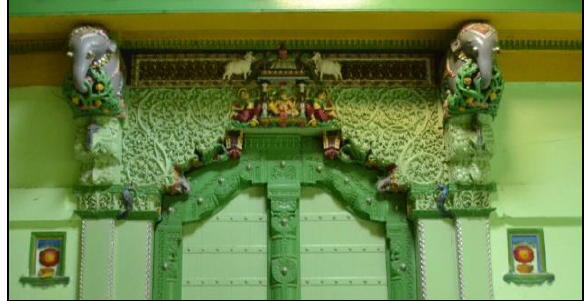
Figure 3. A traditional door highlighting the cultural influences